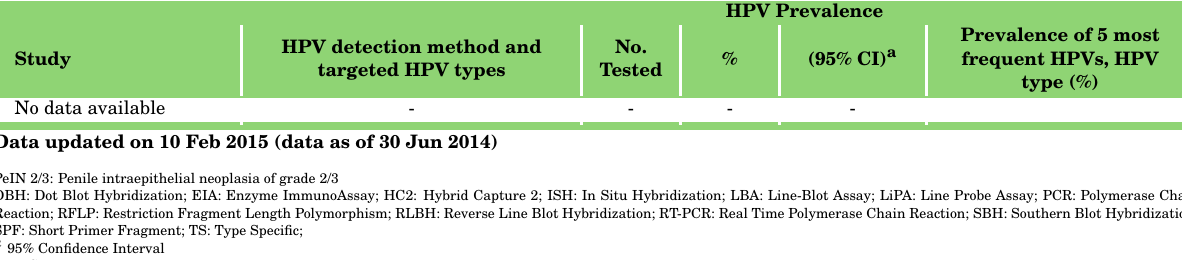
Table 32: Studies on HPV prevalence among PeIN 2/3 cases in